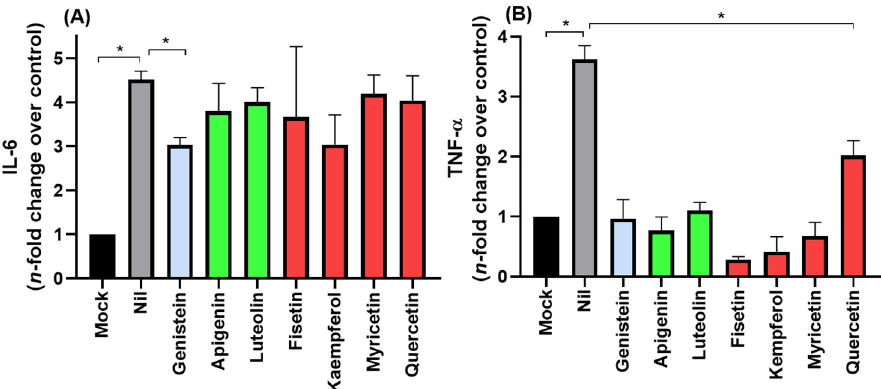
Figure 3. The anti-inflammatory profile of flavonoids was assessed using the ( A ) IL-6 and ( B ) TNF- α levels from uninfected Calu-3 cells supernatant (MOCK), SARS-CoV-2 infected cells without treatment (NIL), and infected and flavonoid treated cells with (10 µ M). Blue, green, and red bars correspond to isoflavone, flavones, and flavonols, respectively. * p < 0.05.